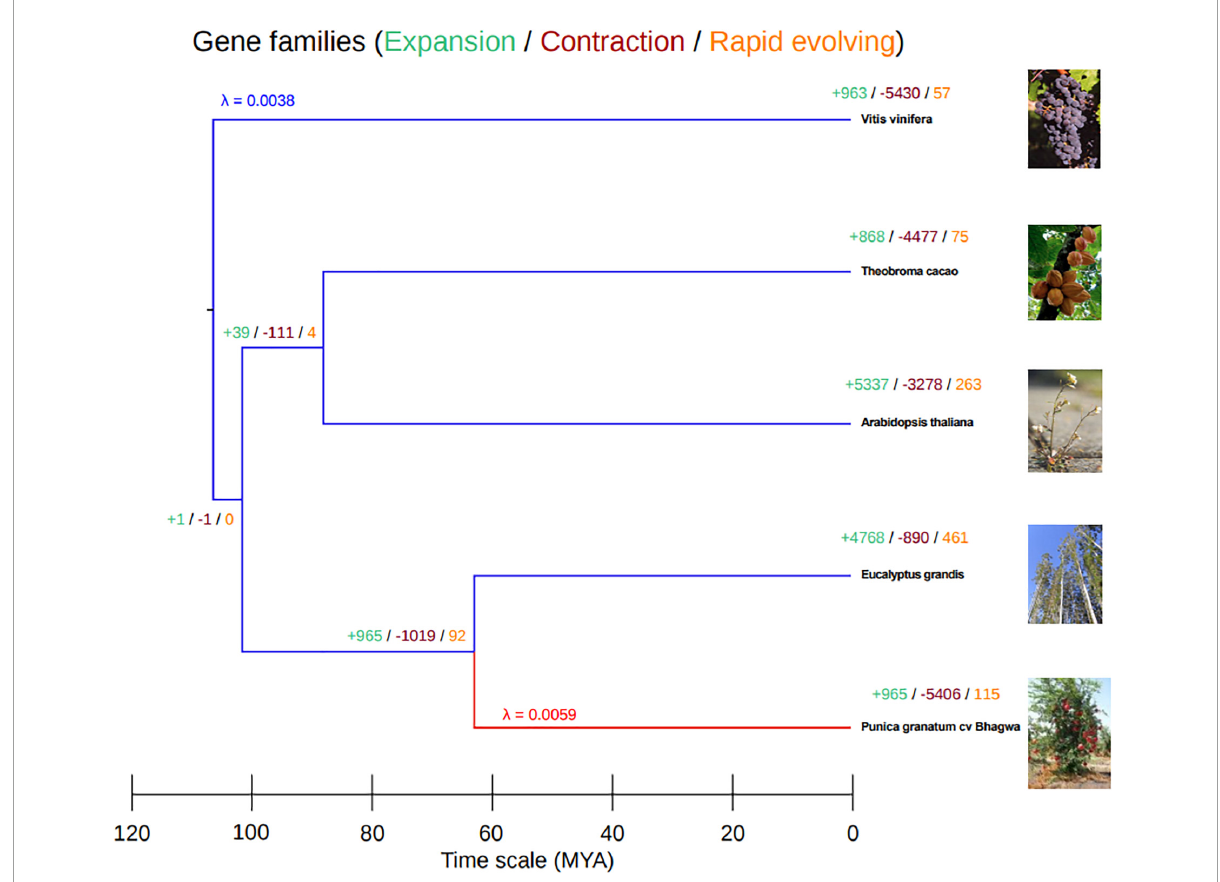
FIGURE7 Phylogenetic tree based on gene families by using Computational Analysis of Gene Family Evolution (CAFE)